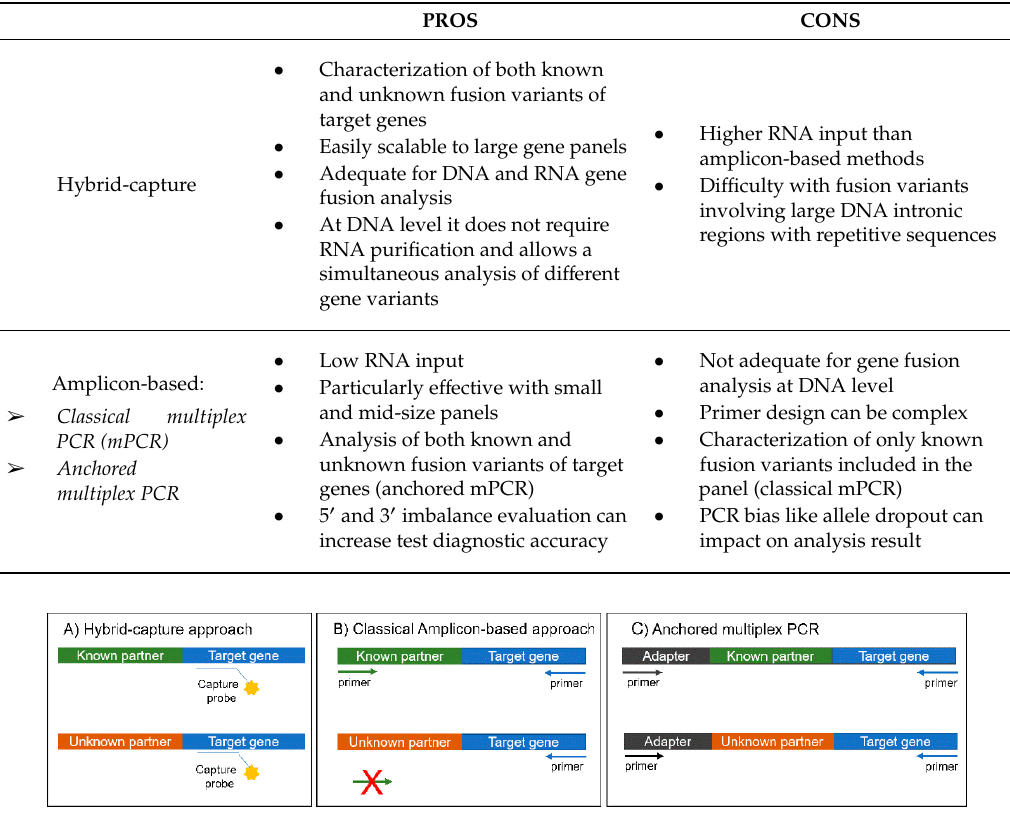
Table 1. NGS Targeted Approaches for Gene Fusion Analysis.